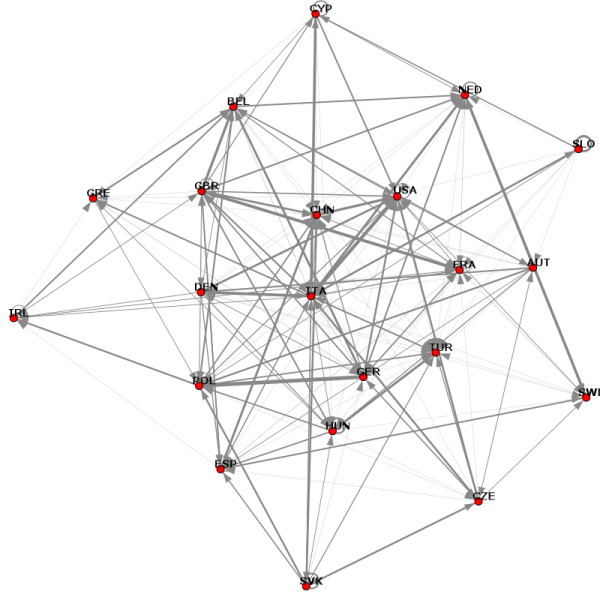
The innermost layer of the network obtained via k-core decomposition.